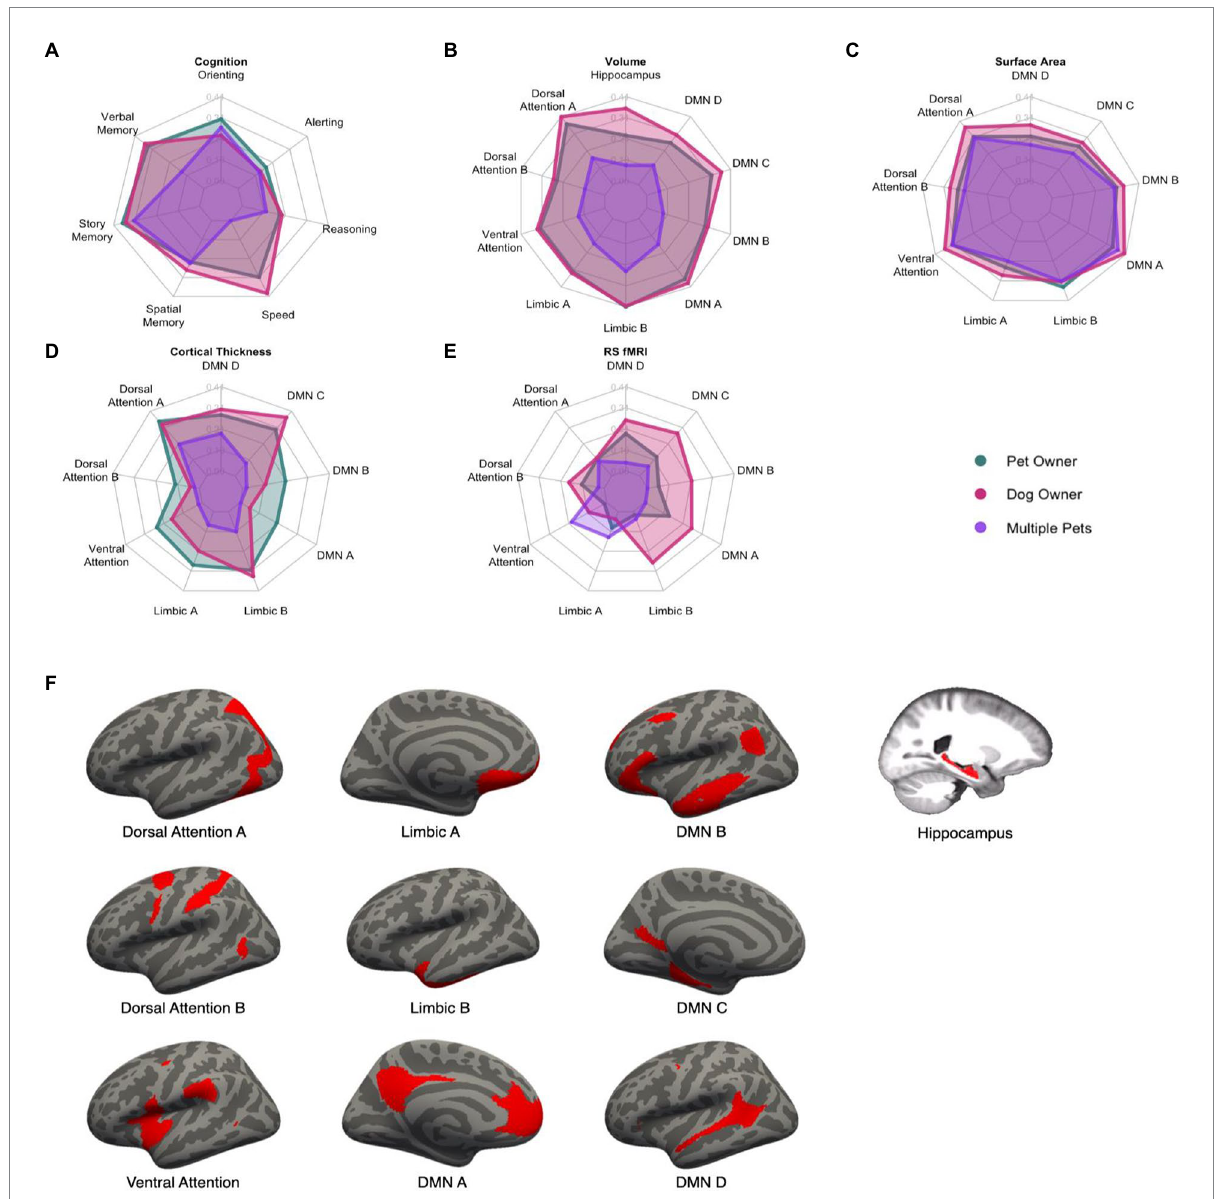
FIGURE 2 Radar plots of the standardized effect sizes of pet ownership (green), dog ownership (red), and owning multiple pets (purple) for cognitive and brain outcomes (A–E) . Higher values indicate a greater difference between the three groups and non-pet owners. Visual depiction of the networks used in the analyses (F) . DMN, Default Mode